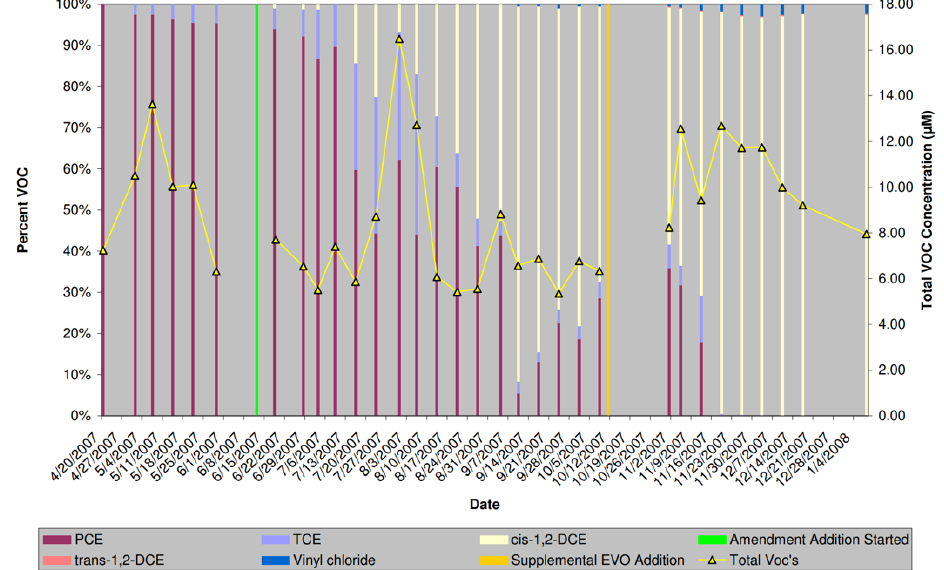
Figure 6. Comprehensive test cell data summary: EVO, HSE-14/HSI-19, HSE-14% VOC, and total VOC concentration.